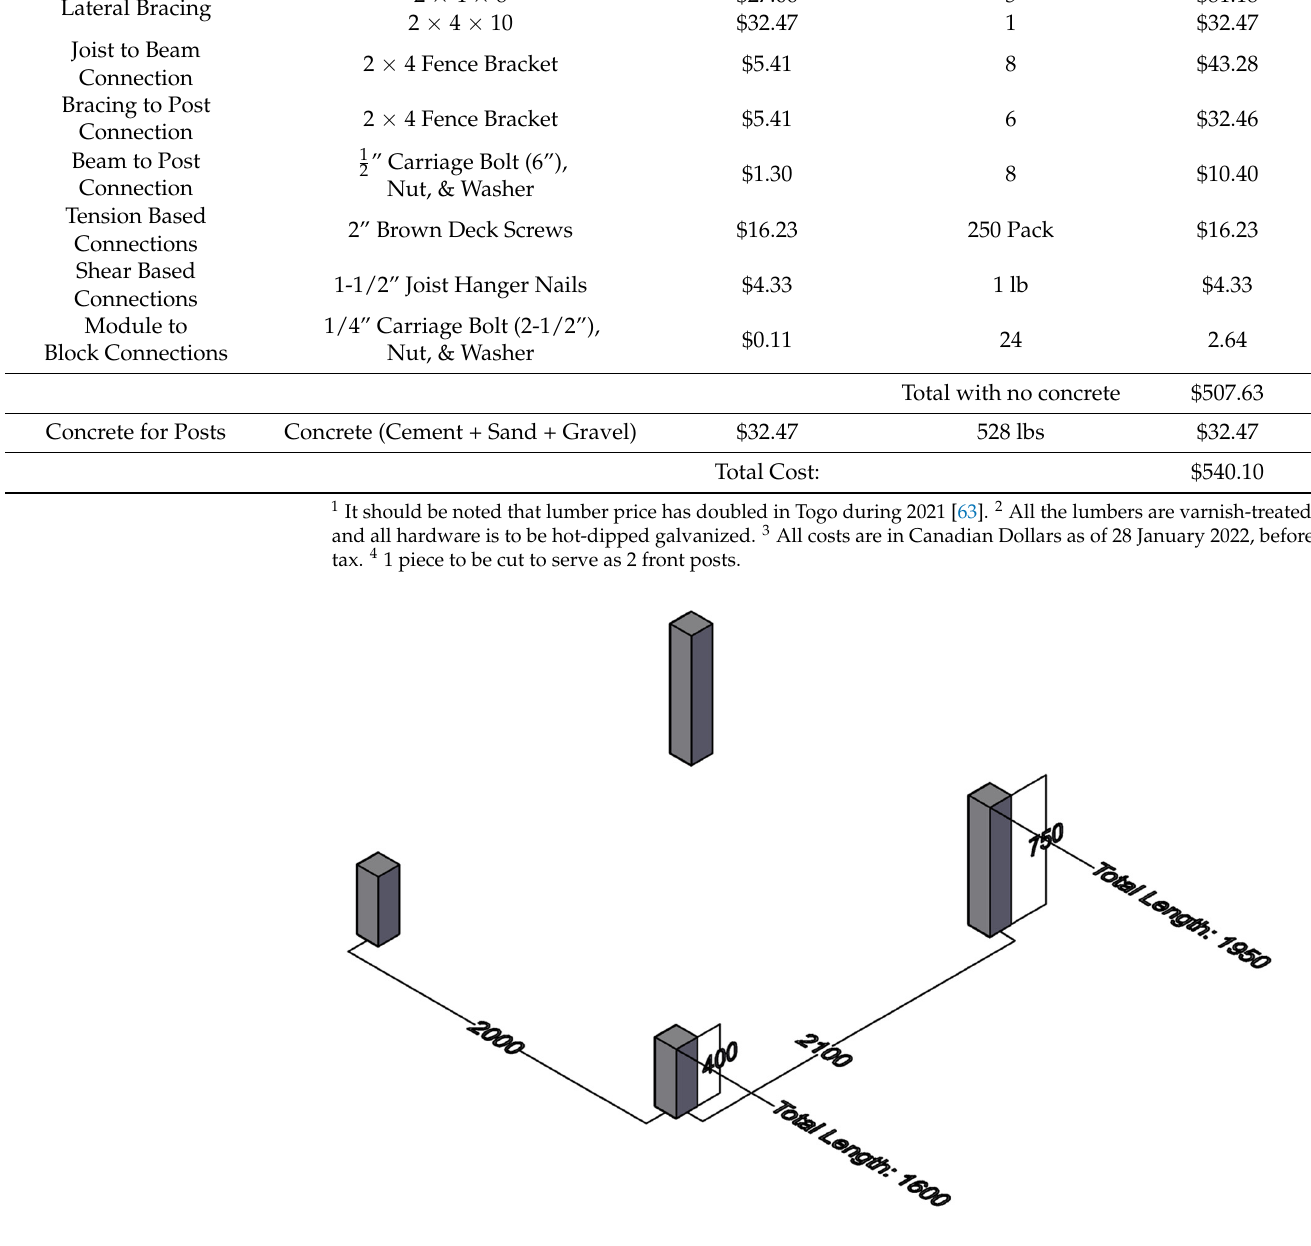
Figure 9. Foundational installment and spacing of 4 × 4 posts.